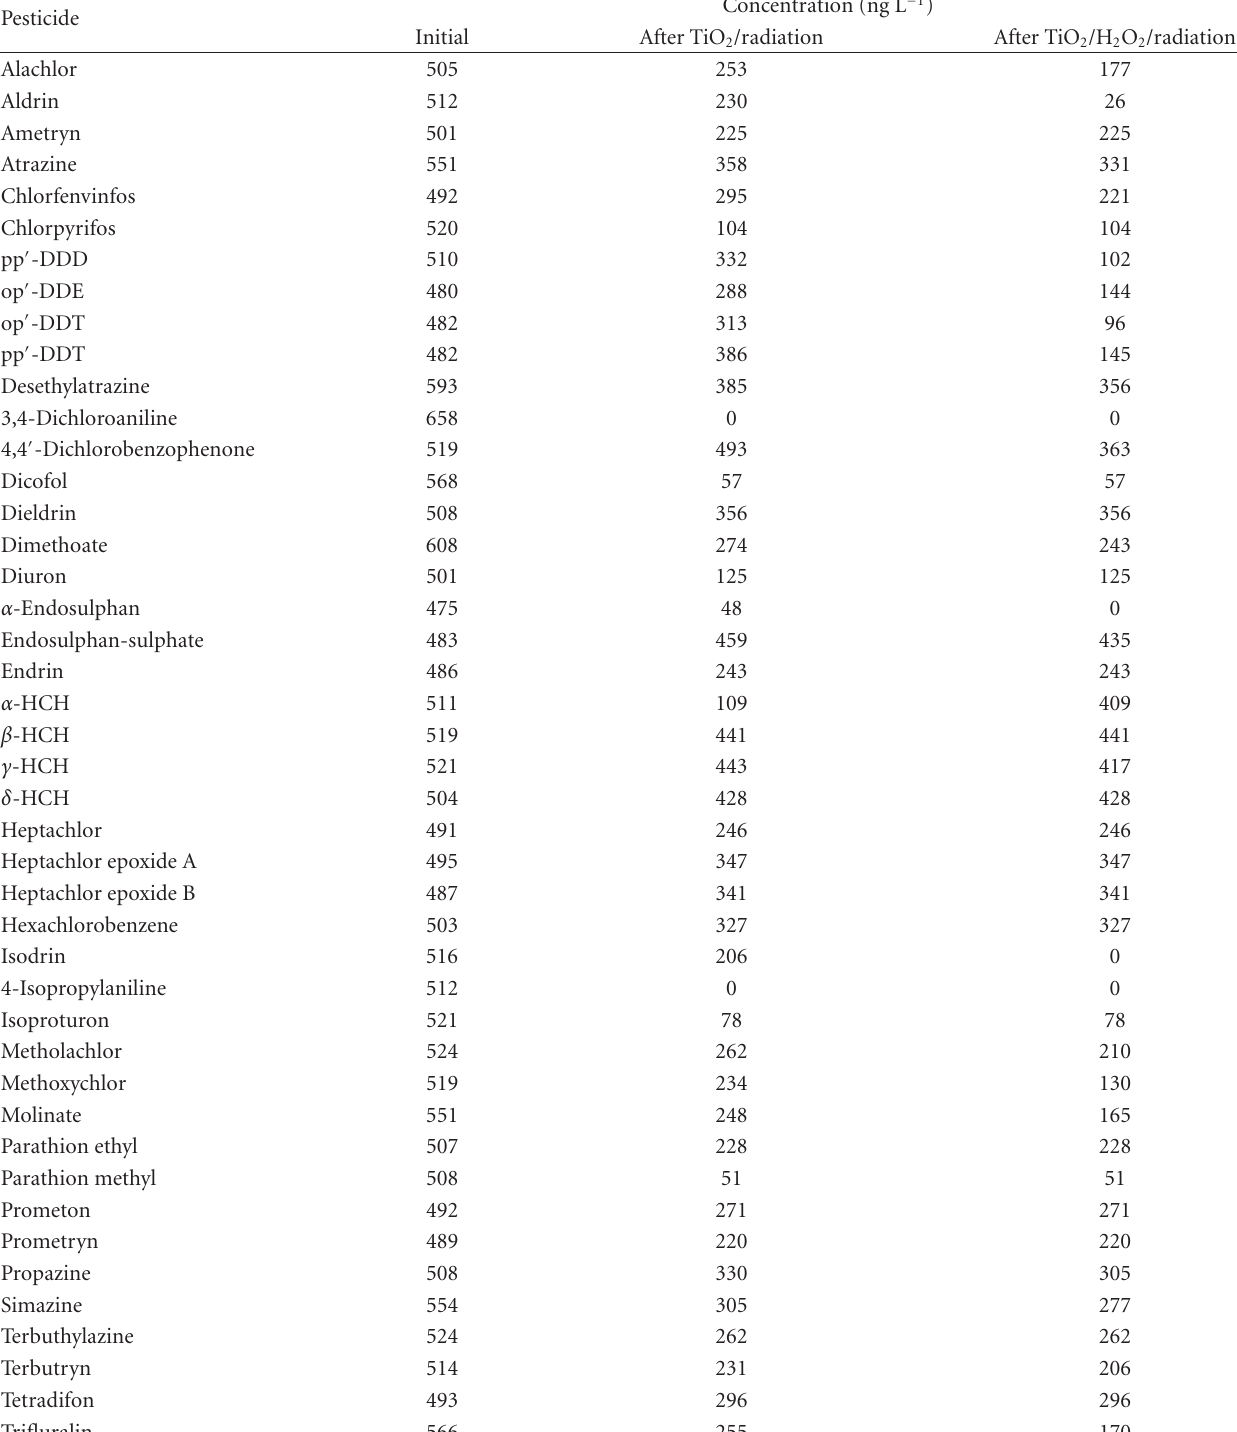
Table 5: Concentration of pesticides in samples in photocatalytic